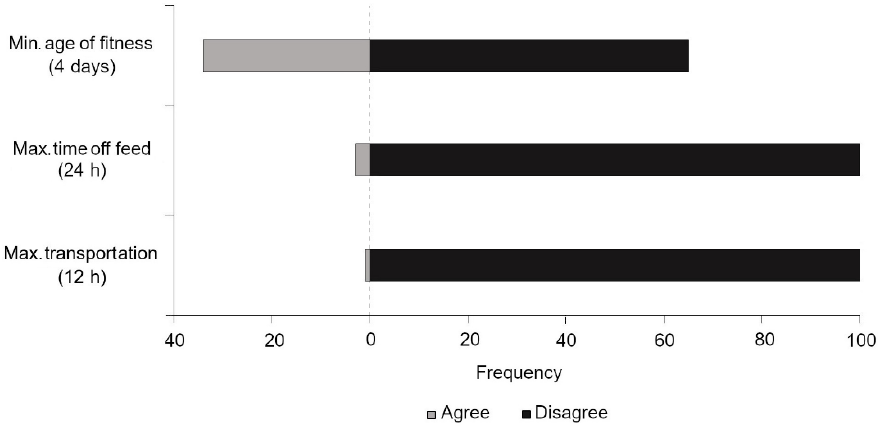
Figure 4. Frequency of veterinarians that agreed or disagreed with certain specifications of calf welfare legislation, where the dashed line represents the point between agreement / disagreement.